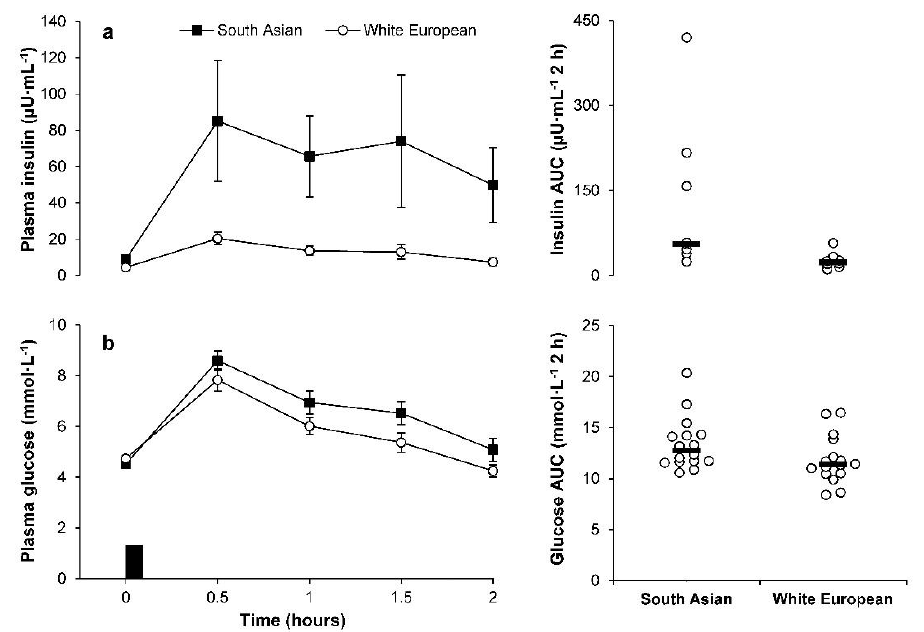
Figure 6. concentrations of ( a ) insulin (top panels; South Asian n = 8, white European n = 8) and ( b ) glucose (bottom panels; South Asian n = 16; white European n = 16) during the oral glucose tolerance test. Data points on left panels represent mean (SEM) for the South Asian ( ■ ) and white European ( ○ ) men. The black rectangle indicates consumption of glucose load. Data points on the right panels represent individual data values ( ○ ) and the solid line indicates the median ( ▬ ).